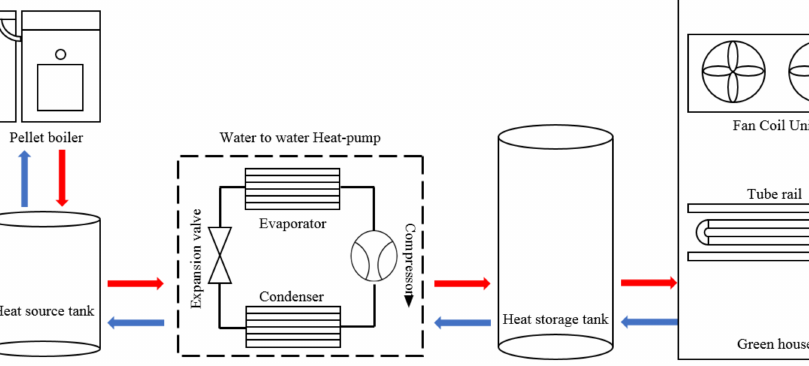
Figure 3. Schematic diagram of the water-to-water heat pump with a pellet boiler as a heat